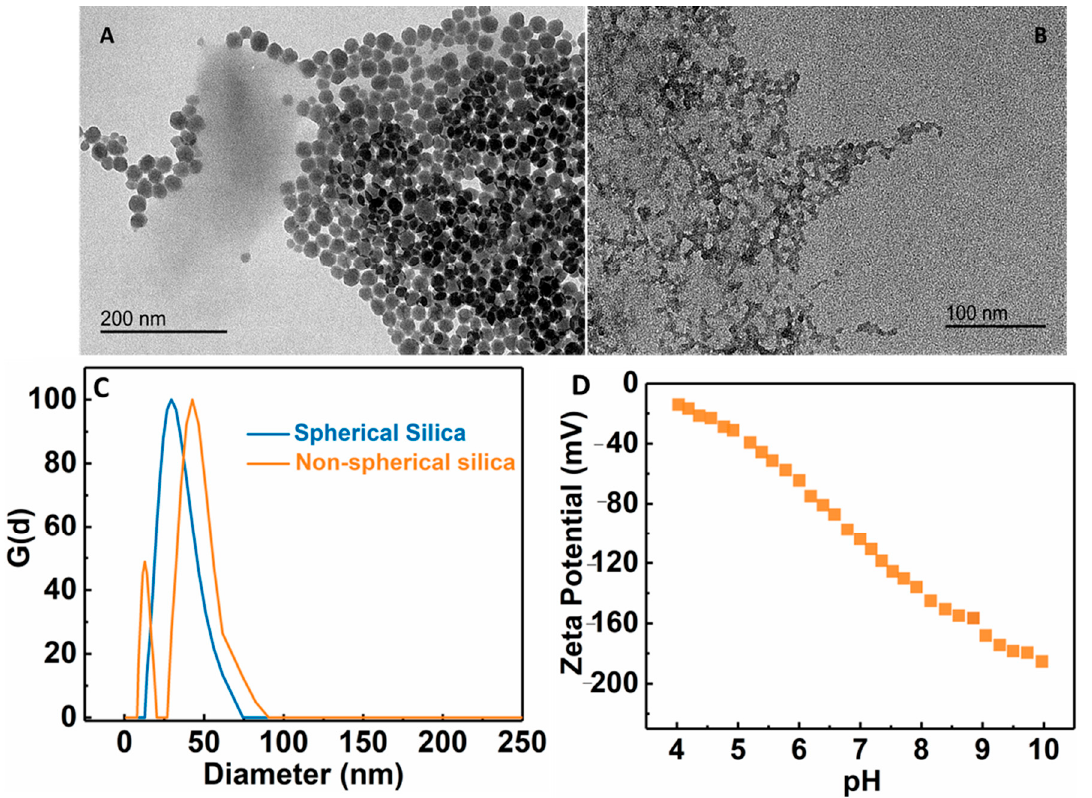
Figure 6. TEM images of ( A ) spherical silica NPs, ( B ) non-spherical silica NPs, ( C ) dynamic light scattering analysis of spherical and non-spherical silica NPs, and ( D ) zeta potential of non-spherical silica NPs as a function of the pH value.